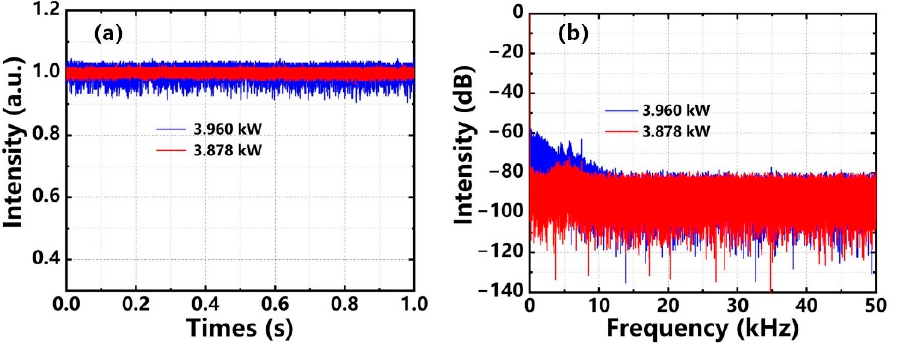
Figure 6. ( a ) Temporal signals of the output laser at 3.878 kW and 3.96 kW; ( b ) Corresponding PSD.